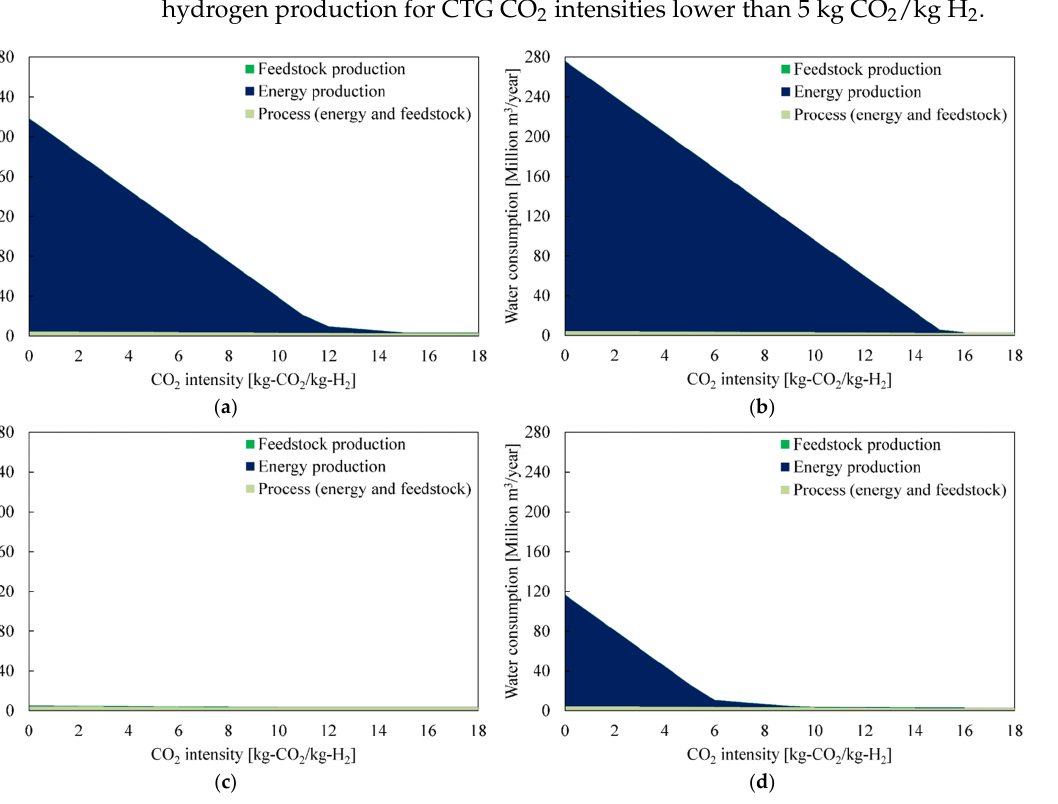
Figure 6. Water consumption as function of the CO 2 intensity for hydrogen production on a cradle- to-gate basis. ( a ) Low-Cost scenario; ( b ) Low Energy Use scenario; ( c ) Water-Energy-Carbon sce- nario; ( d ) Water-Energy-Carbon-Cost scenario.